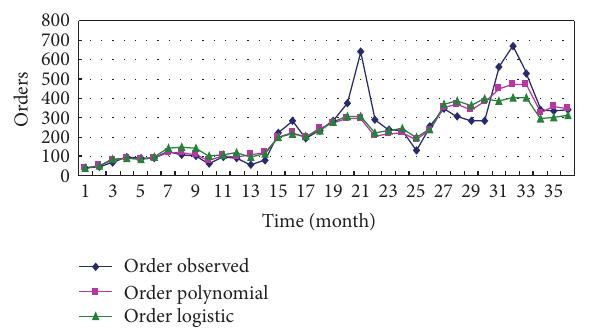
Figure 11: Comparison of the results of the two forecasting models: orders.